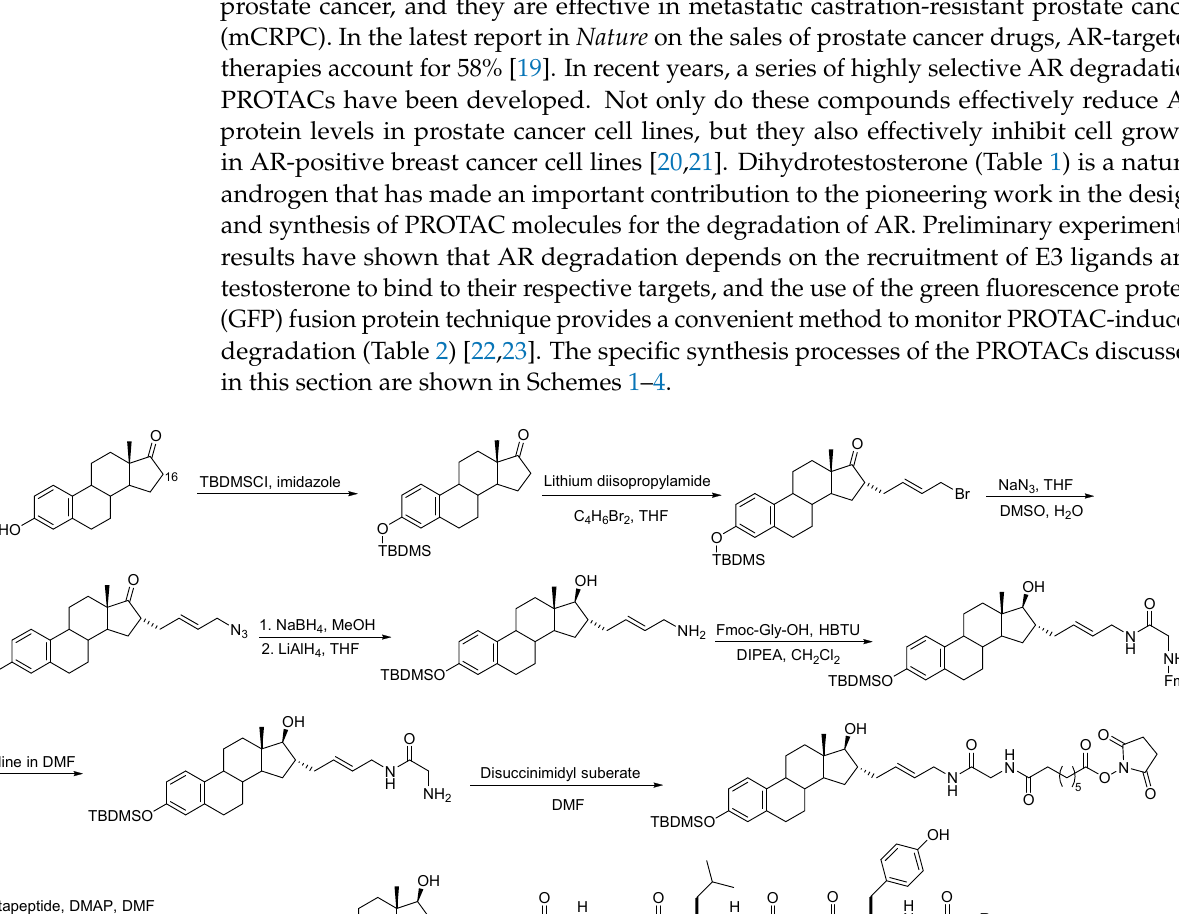
Scheme 2. Synthesis of C7-derivatized estradiol–based PROTAC. Scheme 3. Synthesis of estradiol–based PROTAC.